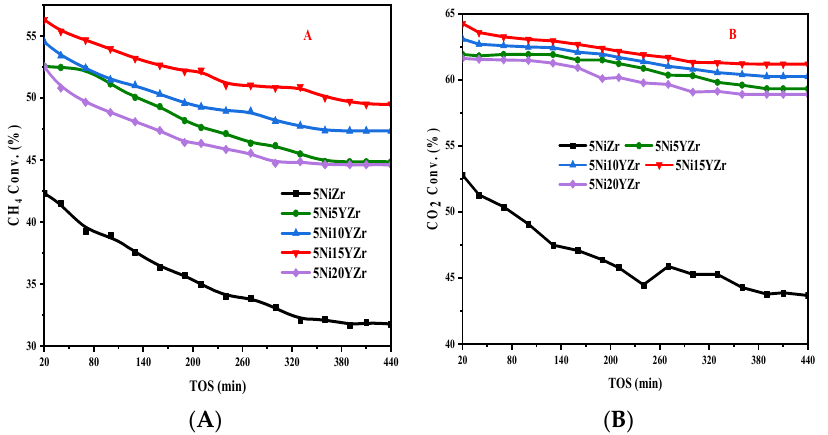
Figure 5. ( A ) CH 4 conversion %; ( B ) CO 2 conversion % versus time on stream at a reaction temperature of 700 °C.